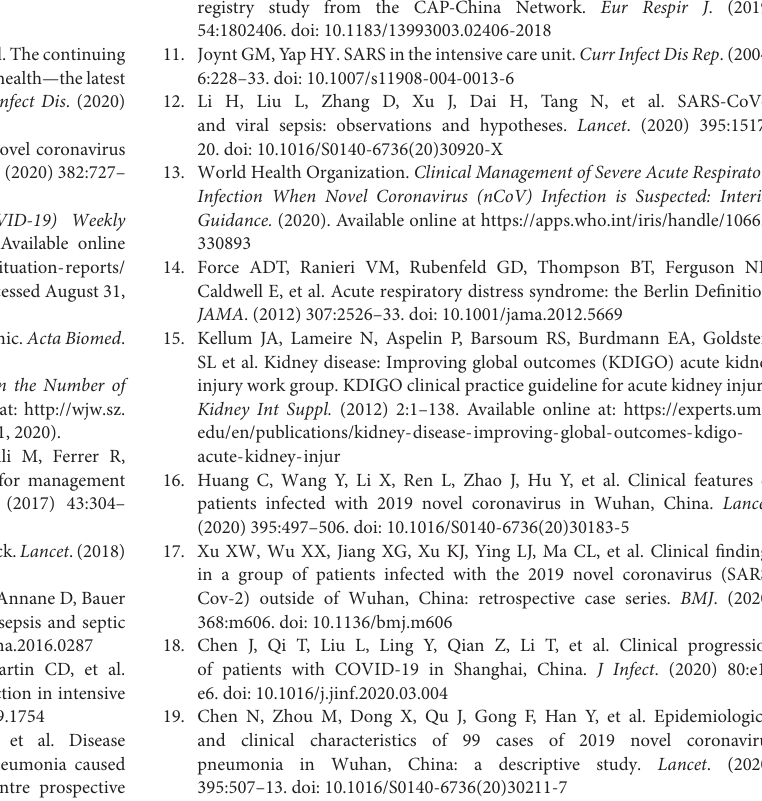
Supplementary Figure S1 | Variable selection process via the LASSO regression model. LASSO regression analysis coefficients for the risk factors of the onset of SARS-CoV-2 infection-induced sepsis (A) . LASSO regression analysis coefficients for the factors associated with the progression to critically ill cases among septic COVID-19 patients (B) . Selection of tuning parameters in the LASSO regression analysis based on 10 cross-validations in regard to the onset of SARS-CoV-2 infection-induced sepsis (C) , and the progression to critically ill cases among septic COVID-19 patients (D)